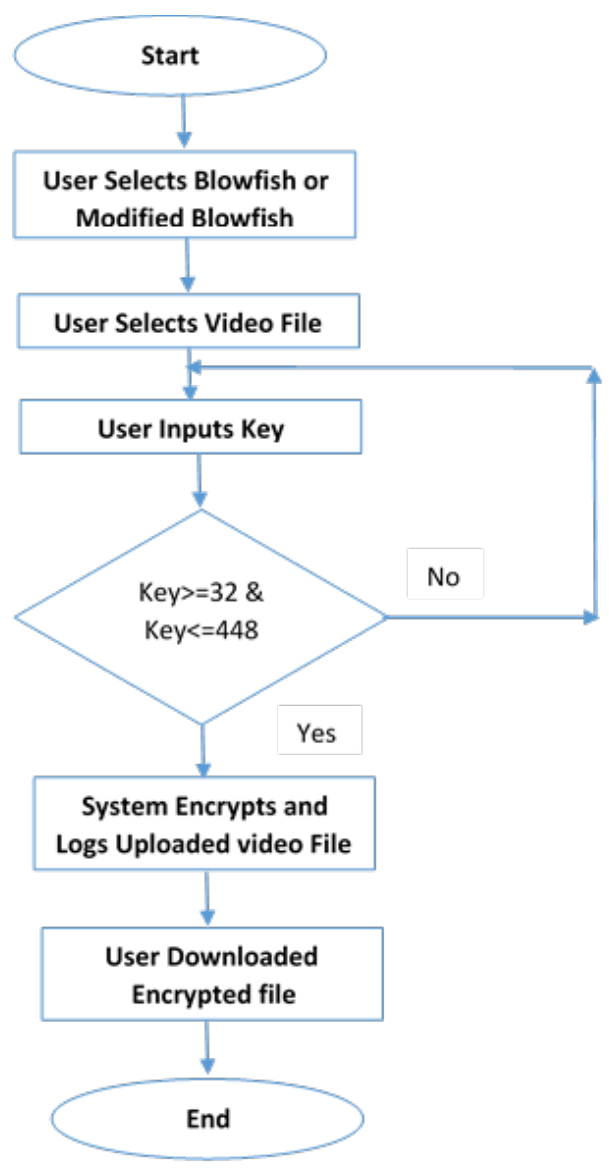
Figure 2. System Flowchart for the proposed modified algorithm. Application